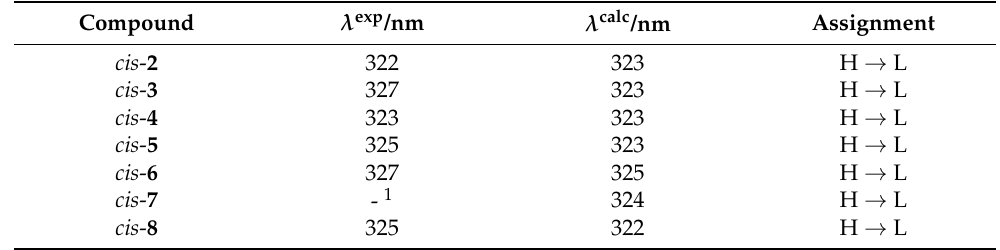
Table 1. Measured and calculated values of absorption maxima in UV-Vis spectra of cis -styryl- thiophene benzylamines, along with transitions responsible for λ max . Calculated data were obtained at the computational model (CPCM)TD-CAM-B3LYP/6–31++G(d) (ACN), with geometries optimized at the M06-2X/6-31G(d) level of theory. The highest occupied and lowest unoccupied molecular orbital are denoted by H and L, respectively.